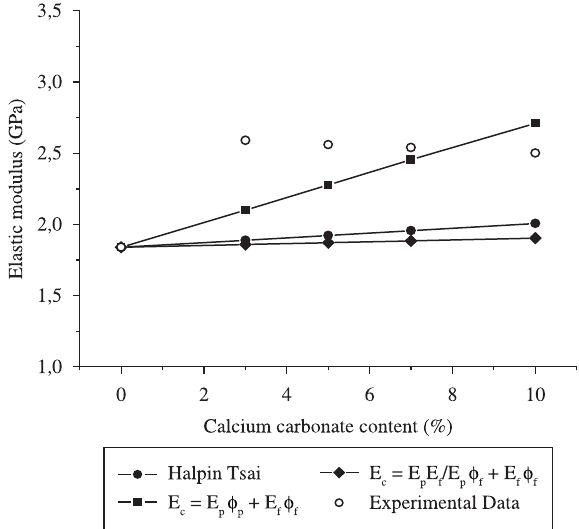
Figure 5. Experimental data of elastic modulus ( ○ ) as a function of calcium carbonate content compared with models used to predict elastic modulus of composites. ( ● ) Halpin Tsai model (Equation 2), ( ■ ) Rule of Mixtures ( Equation 3) ( ♦ ) Inverse Rule of Mixtures (Equation 4).